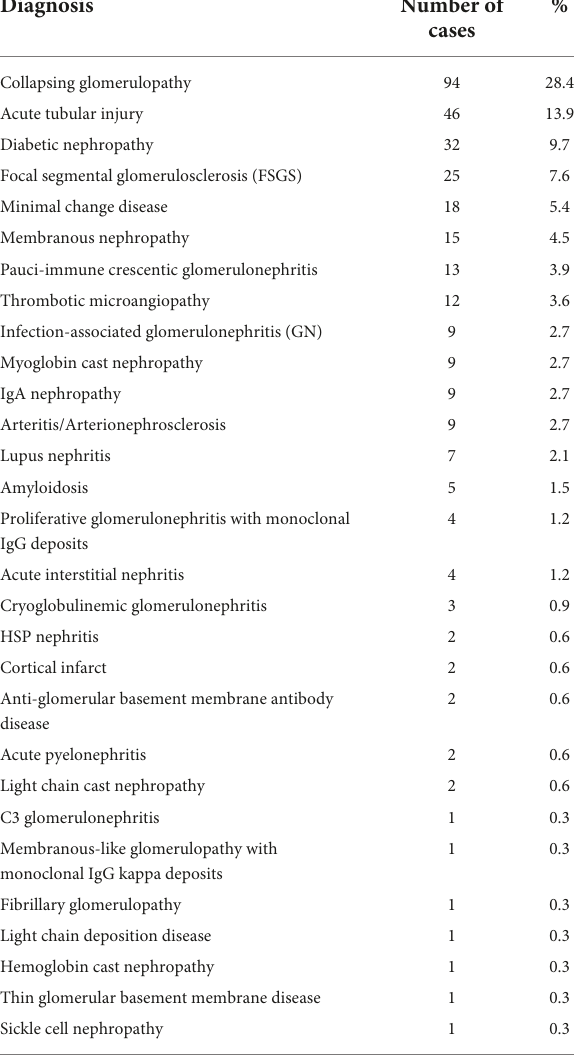
TABLE 1 Biopsy findings of native kidney in patients with COVID-19: Review of case-series reports ( n = 331) (14, 18, 62–67). Diagnosis Number of